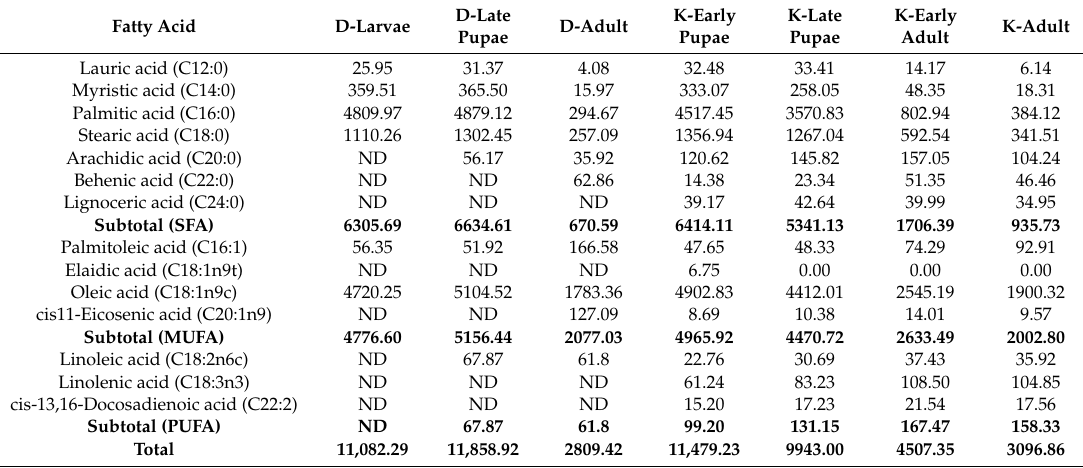
Table 2. Fatty acid composition (mg / 100 g dry matter basis) of di ff erent developmental stages of Italian honey bee drones from Korea (K-) and Buckfast honey bee drones from Denmark